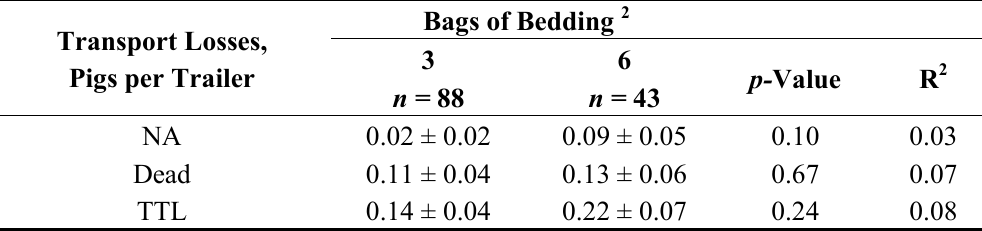
Table 5. Experiment 1. Effects of bedding level on trailers transporting market weight pigs on transport losses 1 .